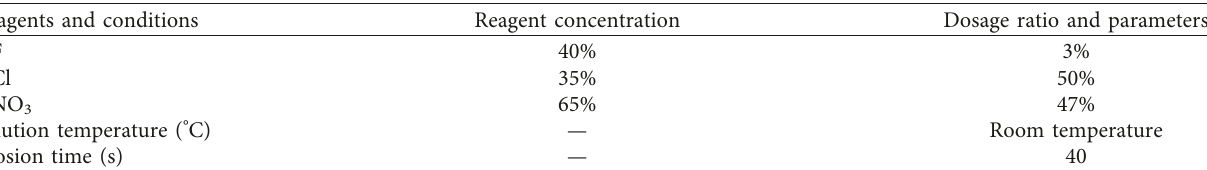
Figure 1: Flow chart of the cube texture detection based on image processing. Table 1: Reagent composition and dosage.